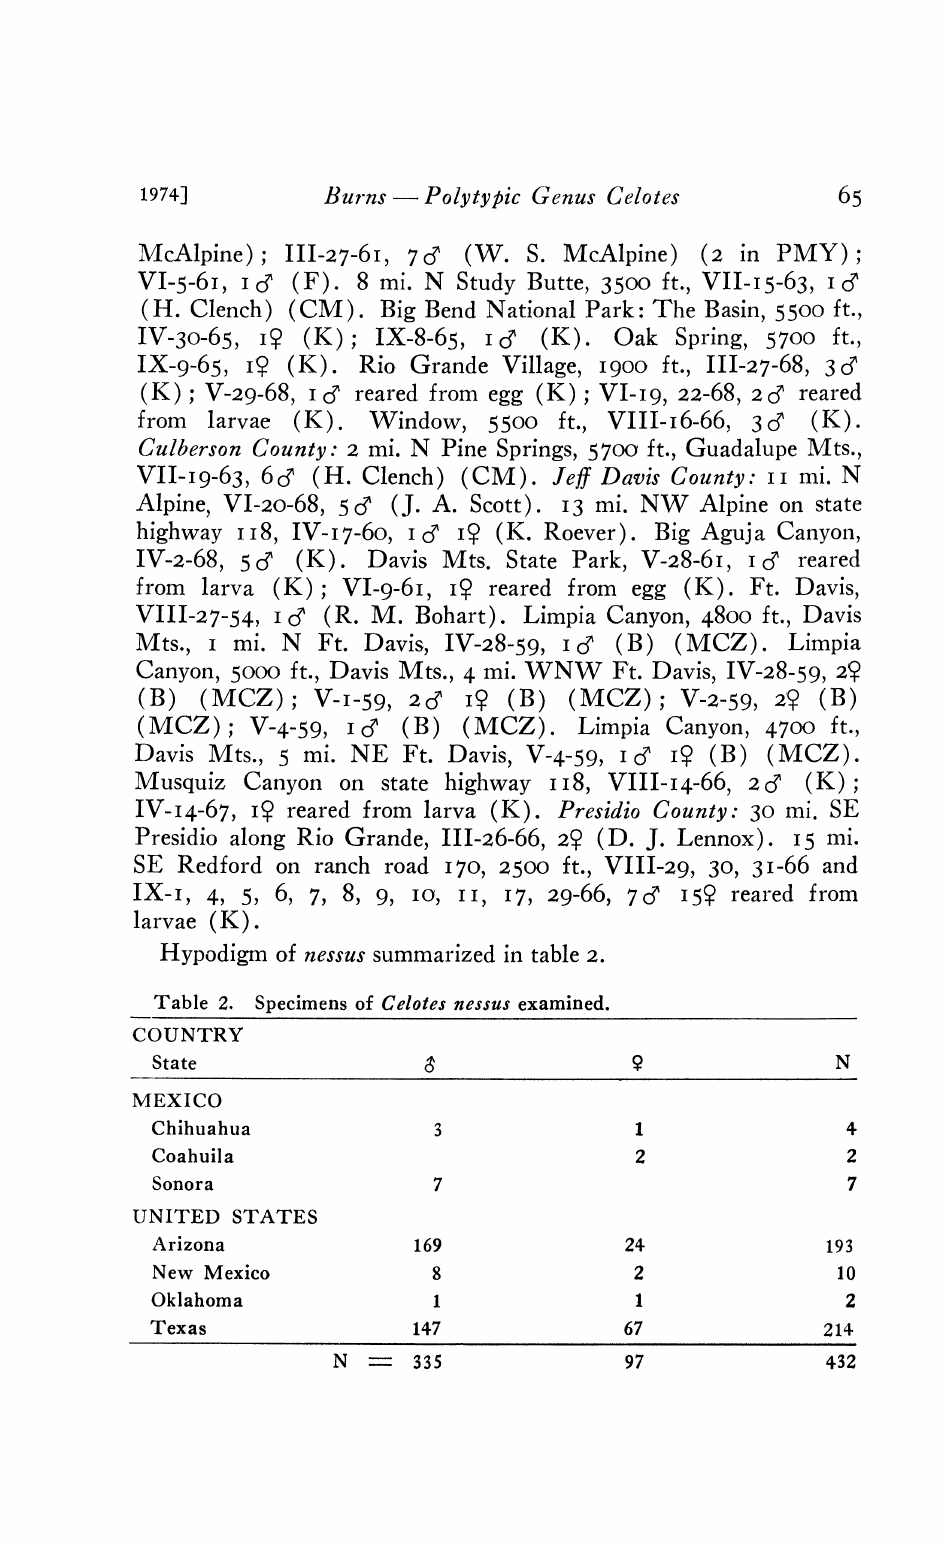
Table 2. Specimens of Celotes nessus